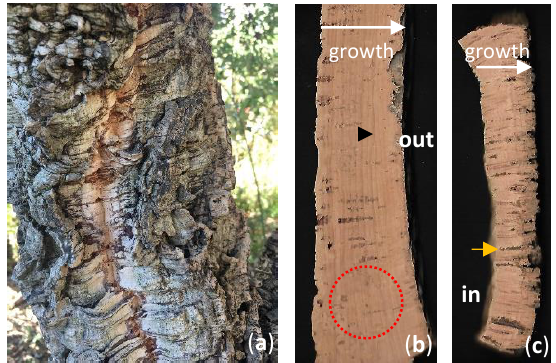
Figure 1. The cork layer of Quercus suber . ( a ) Virgin cork. This cork oak has never been debarked is still displaying its first cork layer. ( b , c ) Different quality types of amadia cork. ( b ) Cork plank thick enough and with very few discontinuities allowing stopper punching (red dots circle). It is possible to distinguish the growth rings (black arrow). ( c ) Example of a reduced-quality cork plank, thin in thickness and intersected by numerous lenticular channels (black arrowhead). White arrows indicate the growth direction from the surface in contact with the trunk and where the phellogen is (also known as cork belly) towards the surface in contact with the environment. In — cork plant inside; out — outermost cork plank surface.